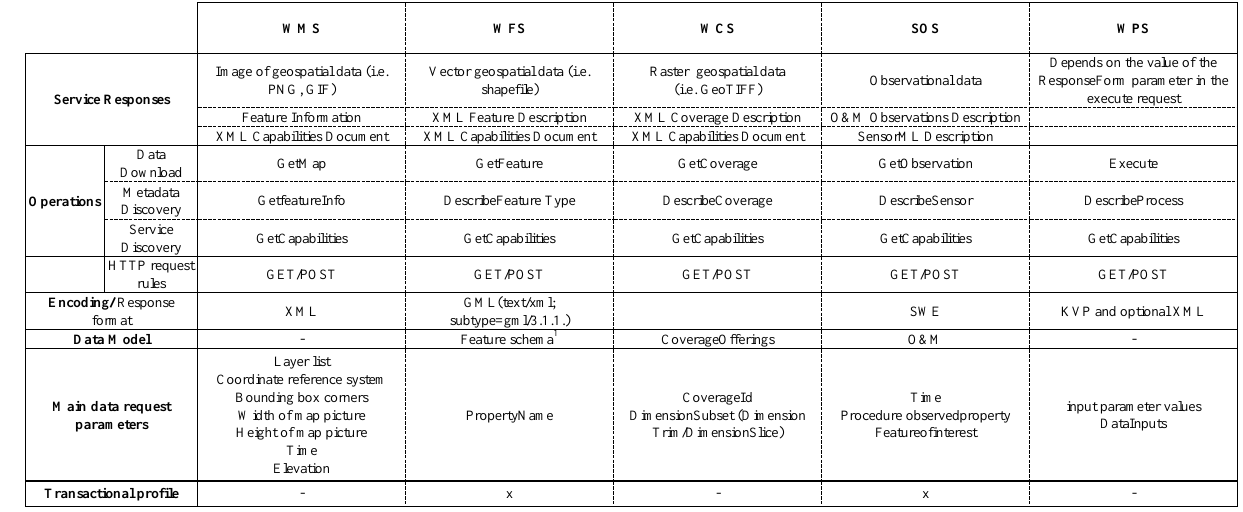
Table. 1 Characteristics and functionalities of geospatial web services